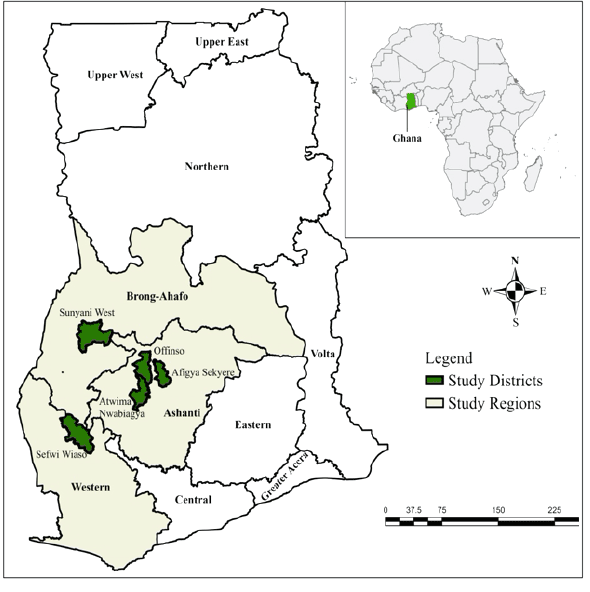
Fig. 2 . Map of Ghana highlighting the study districts and regions. Our synthesis draws on farmer experiences from different parts of the country, spanning five districts in three regions (Western Region, Brong-Ahafo Region, and Ashanti Region). Note: as of October 2020, Ghana’s regional demarcations have changed; figure depicts regional demarcations at the time of fieldwork from 2006 to